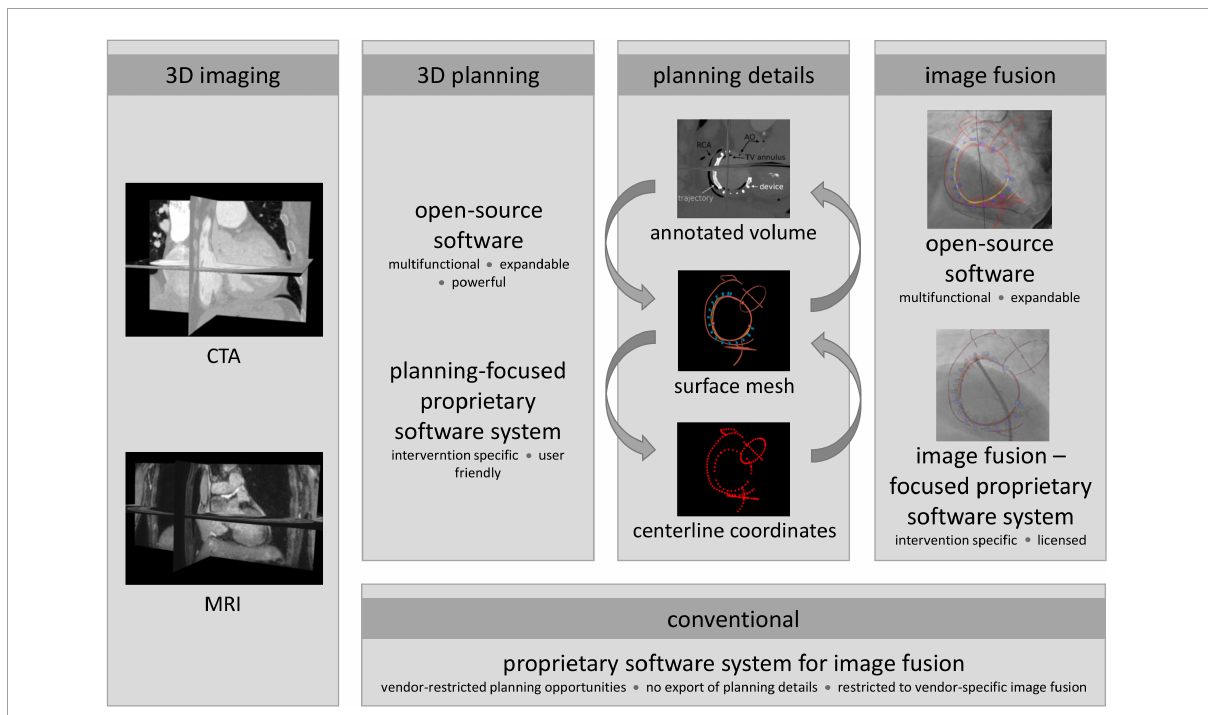
FIGURE1 Proposed and conventional approach to include planning details during interventional procedures. Conventionally, a preprocedural 3D image is prepared for image fusion using an image fusion-focused proprietary software system (PSS), i.e., segmented and planning details added with integrated modules. Due to proprietary and vendor-specific implementation, data generated by independent sources, such as open-source software (OSS) or planning-focused PSS, can usually not be considered for intraprocedural guidance; however, providing more powerful planning support than fusion-focused PSS. To avoid the resulting restrictions, planning details exported from the planning tools as surface meshes, centerline coordinates, or annotated 3D DICOM image volumes were converted to generate an interface to the image fusion software. Thus, enabling the use of vendor-agnostic planning data during image fusion and procedural